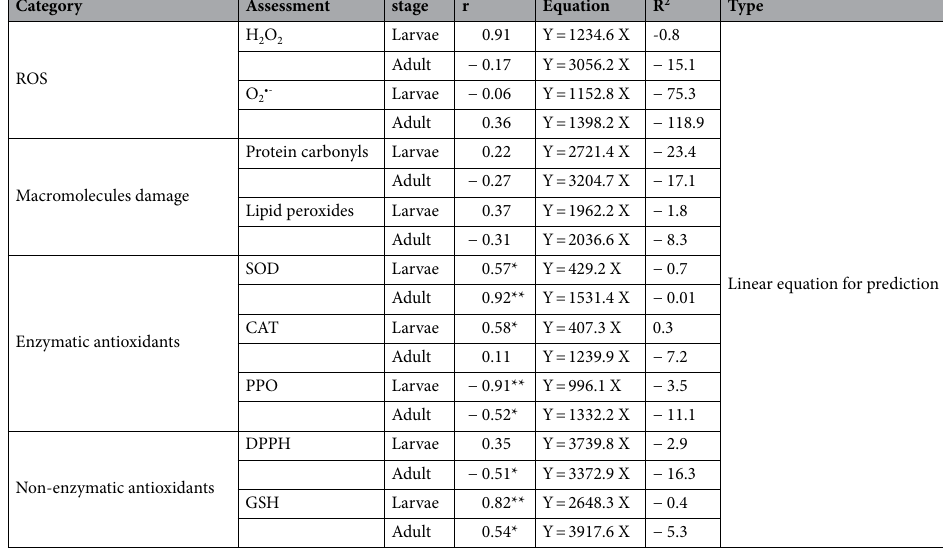
(Fig. 4b). The 0, 0.005, and 0.01 mg/ml malathion concentration created a separate cluster in antioxidant response system of larval H. illucens (Fig. 4c), though, in adult stage 0, 0.005, and 0.015 mg/ml malathion formed a sepa- rate cluster in antioxidant enzymatic and non-enzymatic response in gut homogenates of H. illucens (Fig. 4d). Environmental computing of the effect of different malathion concentration (0, 0.005, 0.01, 0.015, and 0.02 mg/ml) and developmental stage (5th larval instar and adult male) were shown in Fig. 5a–d. These effects were assessed in the form of principal component analysis (PCA). The PCA was done through variance co- variance matrix analysis with two different components. Also, the eigen value tended to be dependent on 2 variables which were classified into first component and second component. The 1st component is different malathion concentration and the 2nd one is developmental stage . The normalization rotation method revealed that the O 2 •- production rate, in groups treated with malathion concentration from 0 to 0.01 mg/ml, had a great ROS levels in larval and adult stages (Fig. 5a). Meanwhile, the macromolecules damage, in the form of protein carbonyls and lipid peroxide, was detected at concentration 0 or 0.02 mg/ ml malathion (Fig. 5b). The variance–covariance analysis showed a high variability of enzymatic antioxidant system along malathion con- centration (Fig. 5c). However, the first component of PCA tended to be localized centric and reflected between non-enzymatic response and malathion concentration (Fig. 5d).